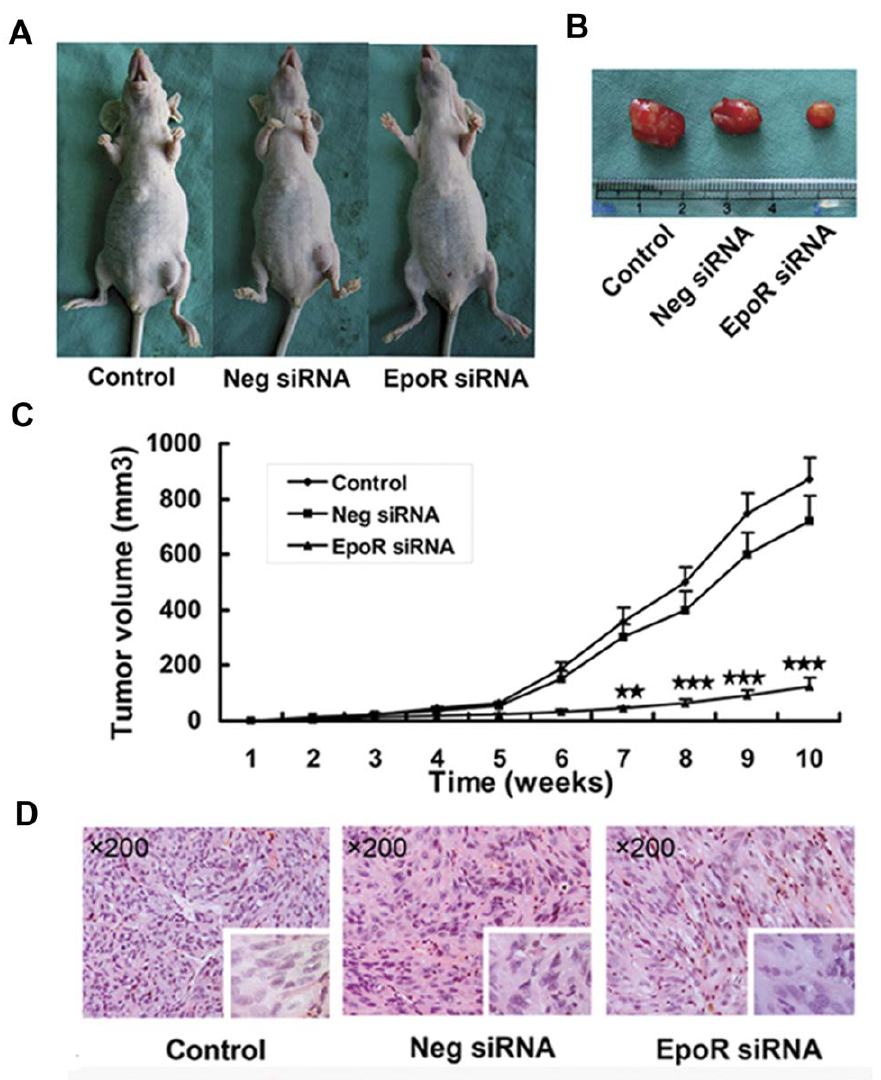
Figure 5. Knockdown EpoR suppresses 786-0 tumor growth in nude mice. Nude mice were subcutaneously inoculated with 2 6 10 6 parental 786-0 cells (Control, n=6), 786-0 cells stably expressing negative siRNA (Neg SiRNA, n=7), or 786-0 cells stably expressing EpoR siRNA (EpoR siRNA, n=10). (A) (B) Tumor sizes after the inoculation for 10 weeks. (C) Changes of tumor size within 10 weeks ( ww : P , 0.01, www : P , 0.001). (D) HE- stained xenograft slides showed the histology of clear cell RCC. Inserts 6